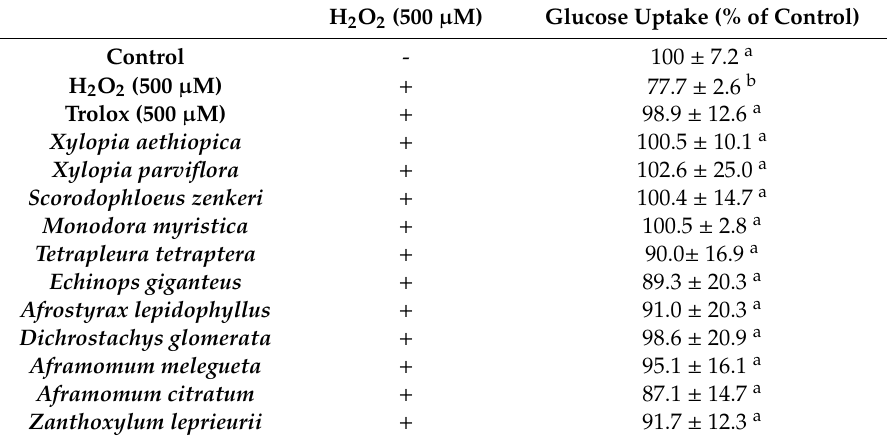
Table 4. E ff ect of plant extracts on oxidative stress modulation of glucose uptake in HepG2